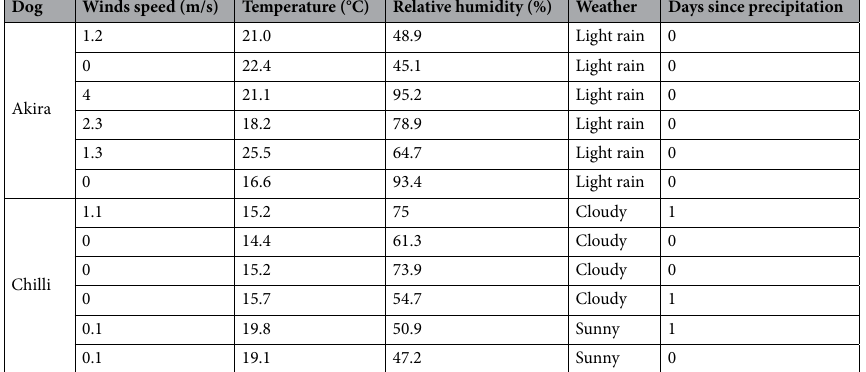
Table 4. Environmental variables during 30 randomized and double-blind experimental searches carried out on trees and untreated wooden pallets in field. The environmental variables include temperature (°C), wind speed (m/s), relative humidity (%) and days since precipitation (> 3 mm), and represents mean (± standard deviation, (SD)) and range of measures for all the 30 experimental